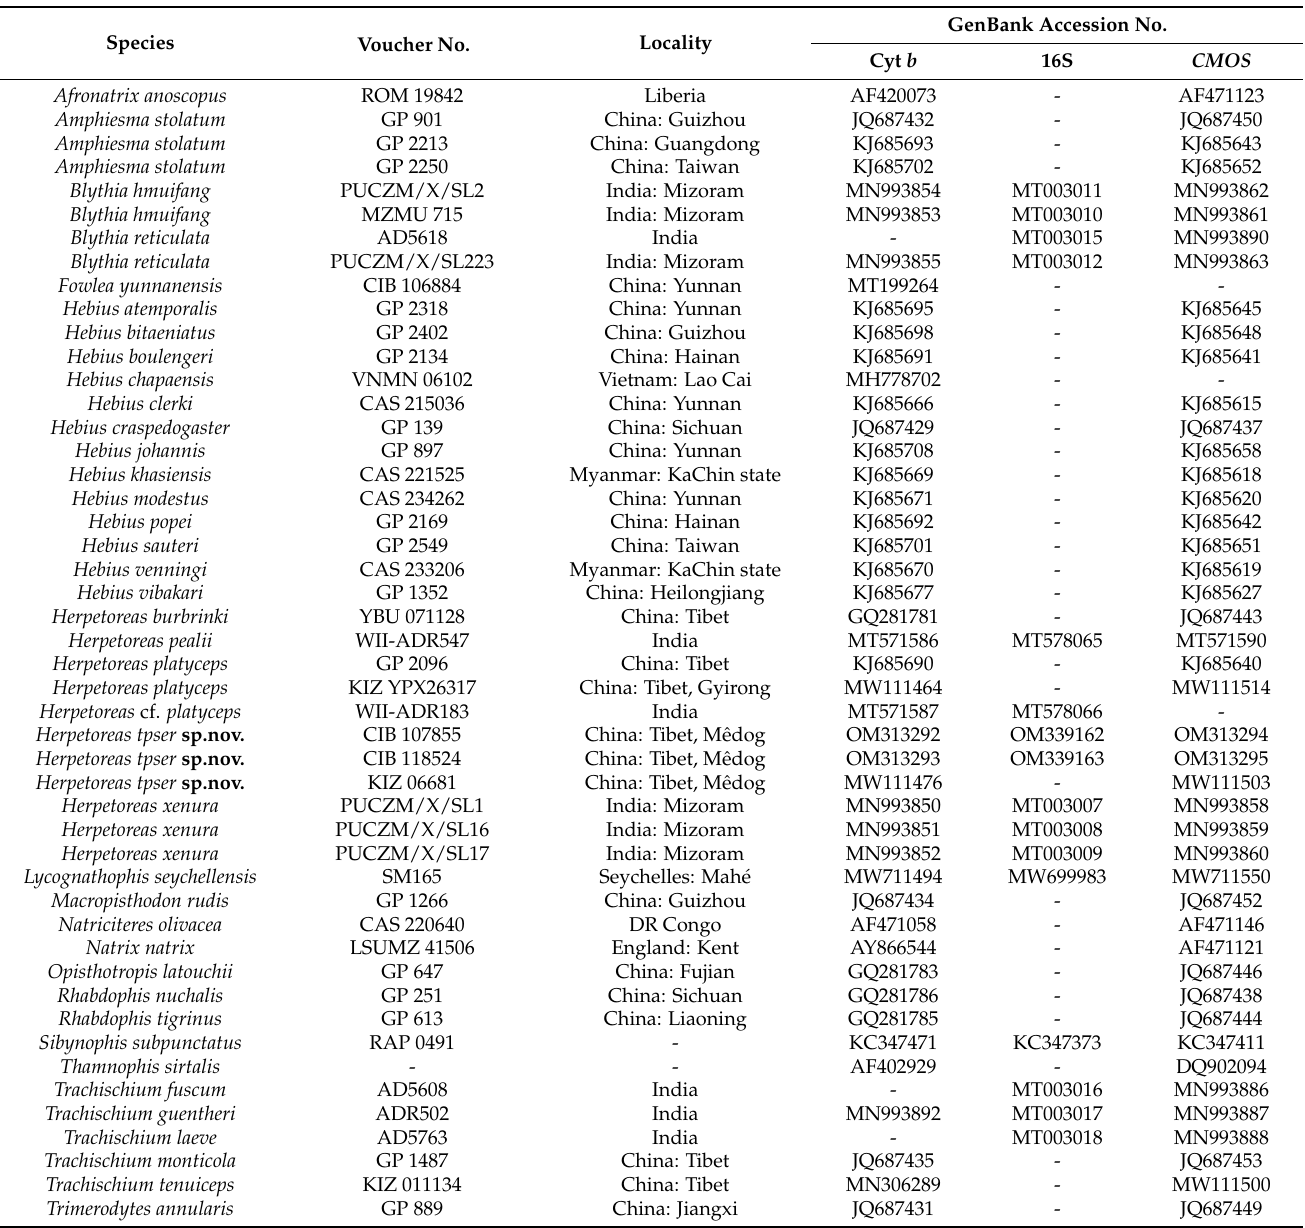
Table 1. Sequences of Herpetoreas and related taxa used in this